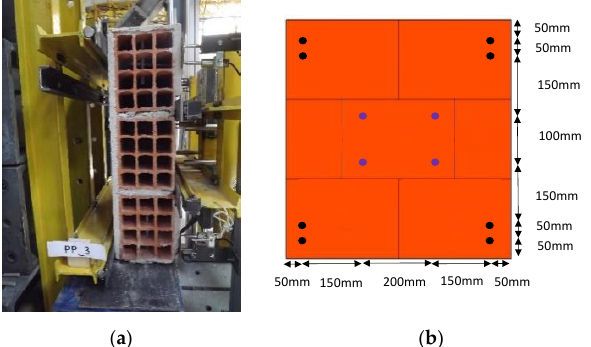
Figure 4. Flexural strength tests parallel to horizontal bed joints: ( a ) profile view of the test setup; and ( b ) schematic layout of the instrumentation (units in millimetres).